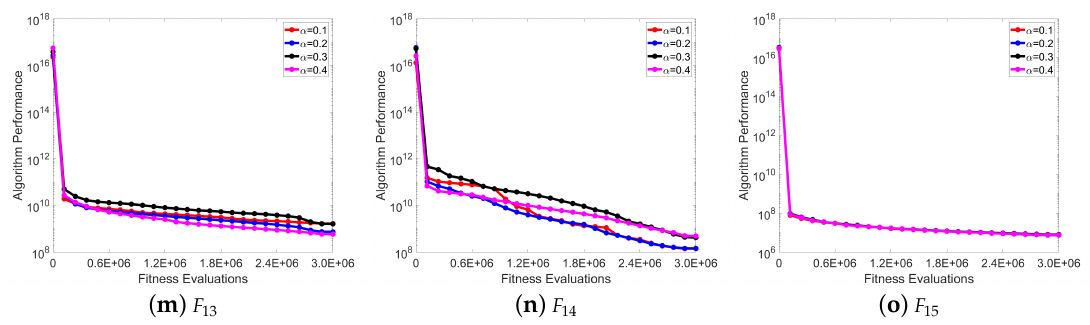
Figure 3. Convergence profiles of different algorithms obtained on the CEC’2013 test suite with 1000